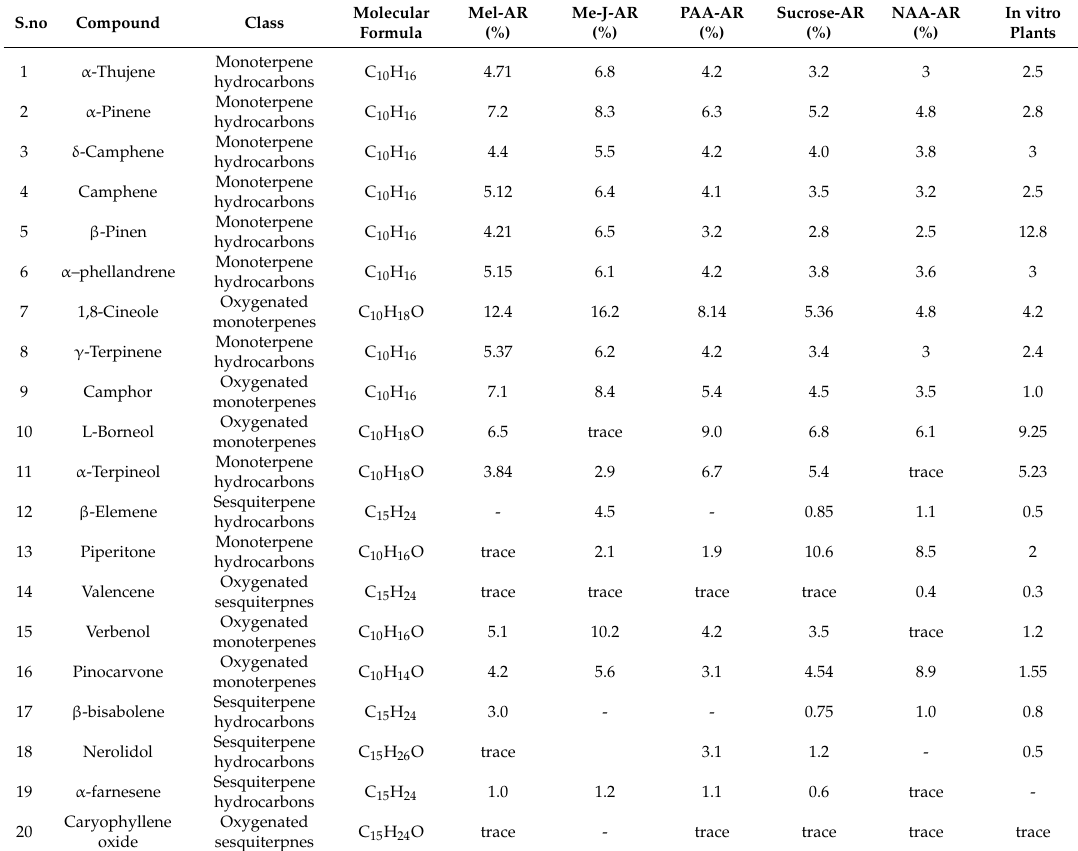
Table 3. Composition of the Essential oils in di ff erent in vitro raised AR samples of A. amygdalina